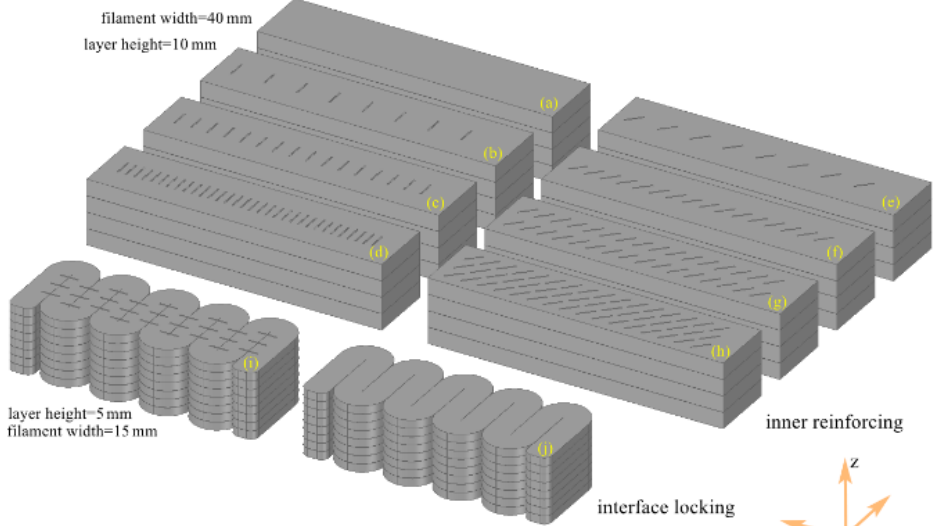
Figure 5. Design of the 3DCP-SIA fabricated samples. ( a ) the printed IR- sample without staples, ( b ) the stapled sample with 20 mm spacing and 90 ◦ , ( c ) the stapled sample with 10 mm spacing and 90 ◦ , ( d ) the stapled sample with 5 mm spacing and 90 ◦ , ( e ) the stapled sample with 20 mm spacing and 45 ◦ , ( f ) the stapled sample with 10 mm and 45 ◦ , ( g ) the stapled sample with 10 mm and 45 ◦ in two rows, ( h ) the stapled sample with 10 mm and 45 ◦ in three rows, ( i ) the IF- sample with staples, and ( j ) the IF sample without staple. Table 2. Name and parameters of the test samples.